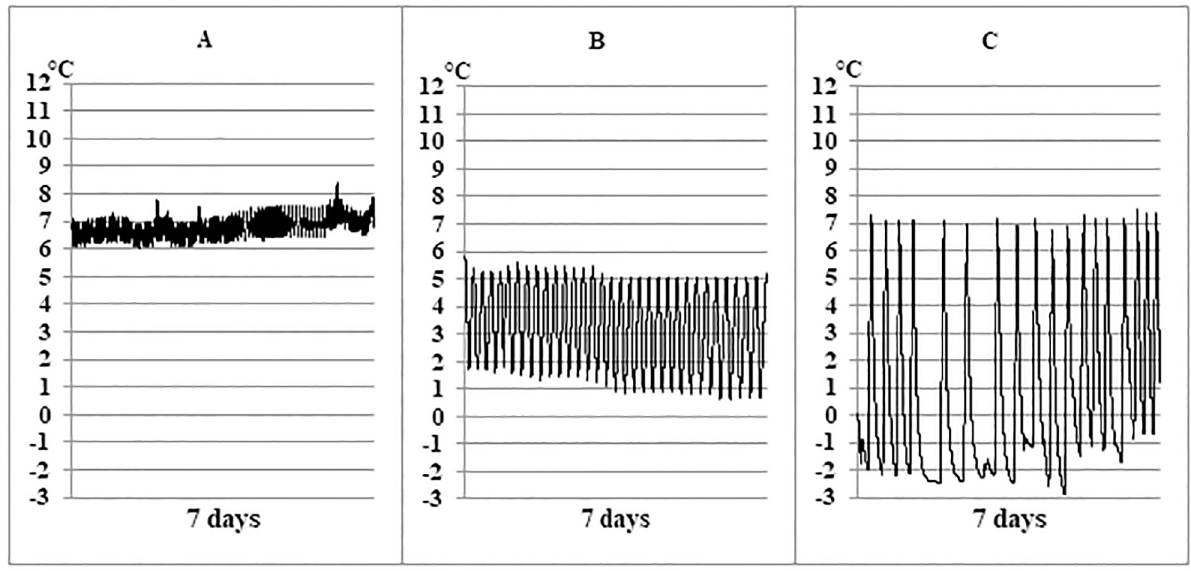
Fig 3. Examples of temperature recordings in three different refrigerators. All data were recorded at 1-minute intervals over 7 days. The graphs illustrate common problems regarding temperature cycling range and mean temperature: A: an adequate cycling range of 3˚C with a too-high mean temperature at approx. 7˚C; B: a cycling range of 5.5˚C with a too-low mean temperature at approx. 3.5˚C; C: a too-high cycling range of 10˚C and a too-low mean temperature at approx. 2˚C.